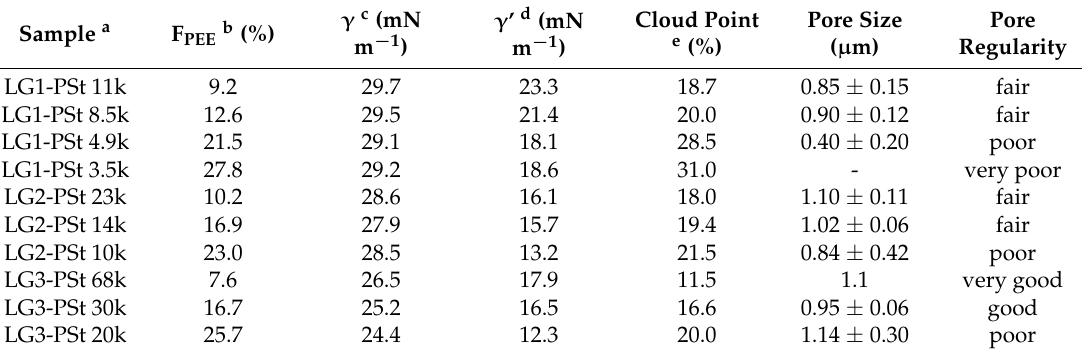
Table 1. Summary of BF film surface morphology produced by